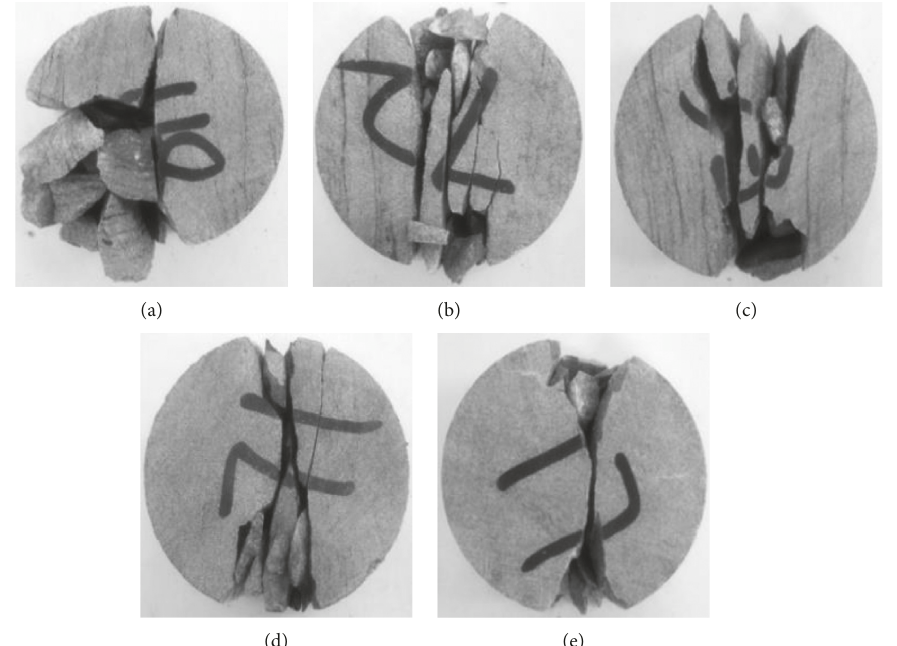
Figure 9: Failure of specimens with different water contents at a strain rate of 73.16 s − 1 : (a) ω � 0.31%; (b) ω � 0.54%; (c) ω � 0.71%; (d) ω � 0.93%; (e) ω �